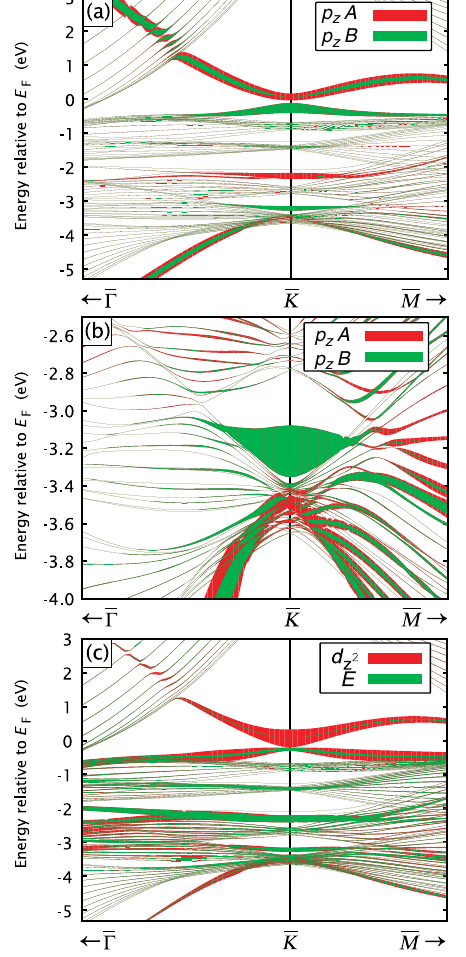
FIG. 7. Dynamic hybridization in the band structure of graphene on Ni(111). The thickness of the lines indicates the band character. (a),(b) Thickness corresponds to the carbon- p z contribution in sublattice A (directly above Ni, red lines) and sublattice B (no Ni directly underneath, green lines). (c) Thickness corresponds to contributions from the d orbitals of the topmost Ni atom, where E ¼ ð d xy ; d xz ; d yz ; d x 2 (cid:3) y 2 Þ . In all panels, only the majority spin is shown. The minority spin is qualitatively the